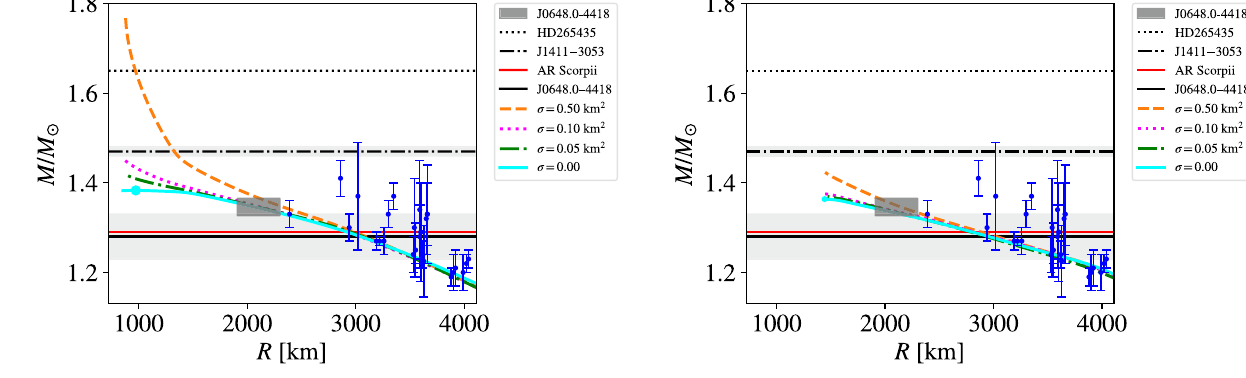
Fig. 2 Same as Fig. 1, but considering the 12 C threshold for equation of state